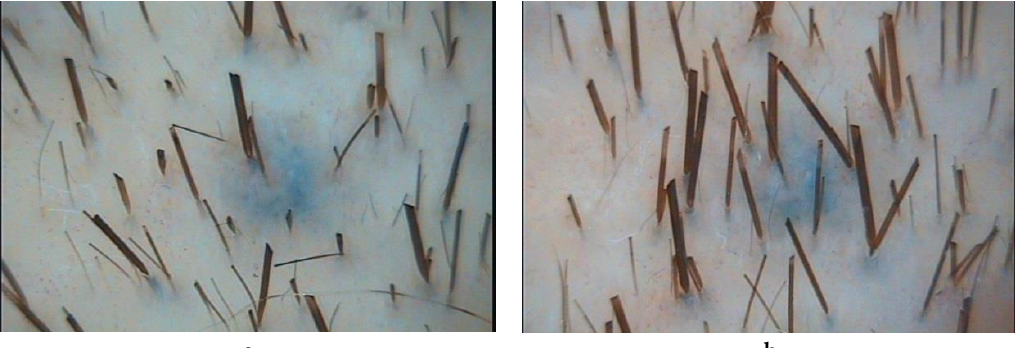
Figure 1. Trichoscopy (phototrichography) of a patient who received an injections of platelet-rich plasma: a —before treatment; b —after treatment. Magnification × 60.